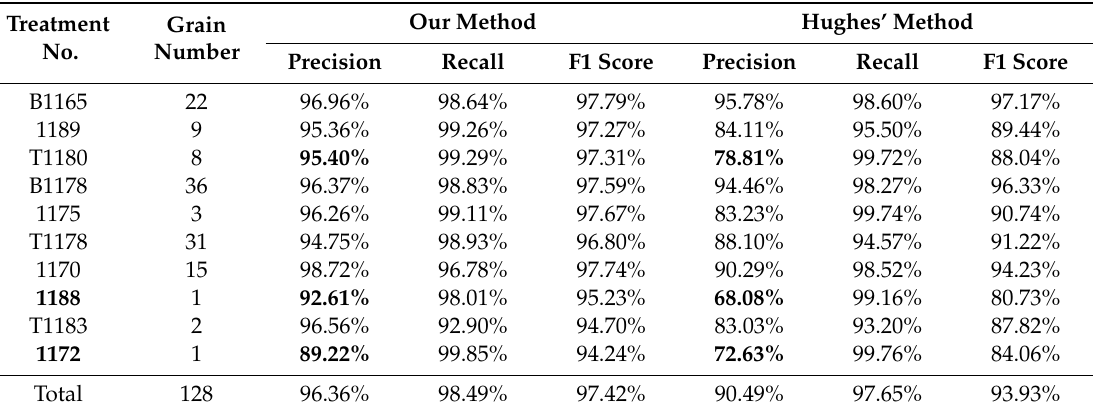
Table 1. Detection results of the proposed method and Hughes’ method in 11 wheat spikes. Treatment